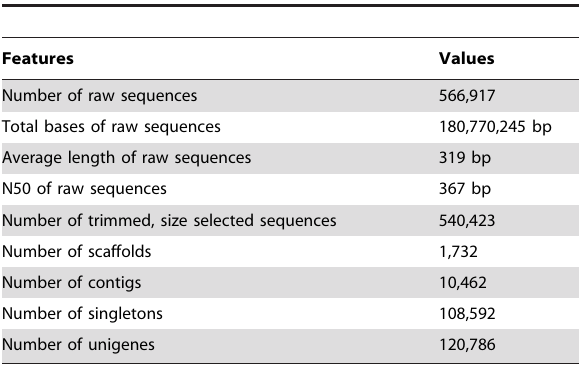
Table 1. Summary statistics of the ESTs generated from the Fujian oyster through